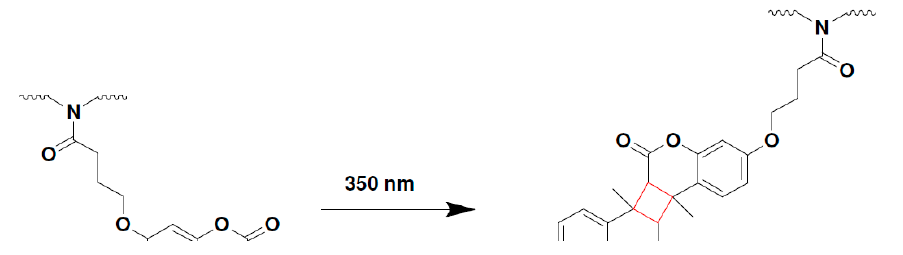
Figure 53. Coumarin side-groups undergoing [2 π + 2 π ] cycloaddition reaction upon UV irradiation. Reproduced with permission from [375]. Copyright © 2022 Elsevier.